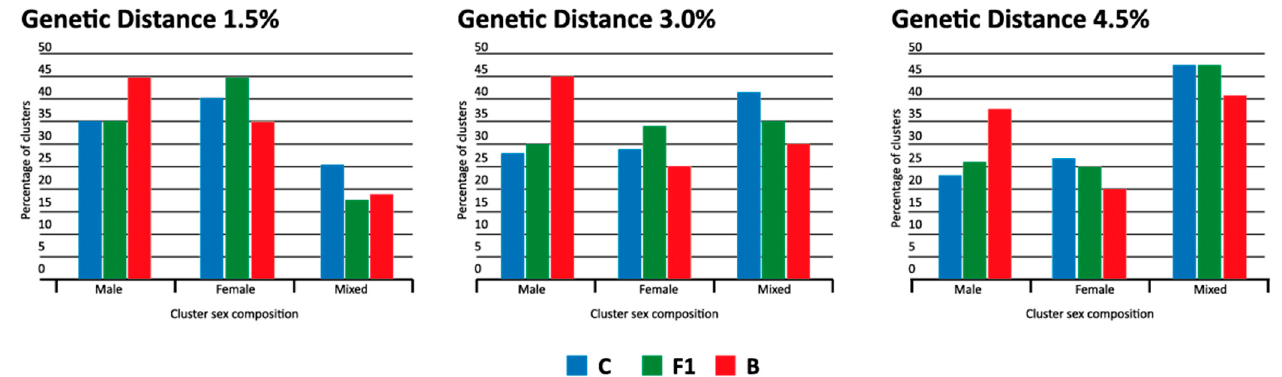
Figure 4. Percentage of clusters composed only by men or women and mixed clusters (clusters composed by men and women), for subtypes B, C and F1, identified with three genetic distances.